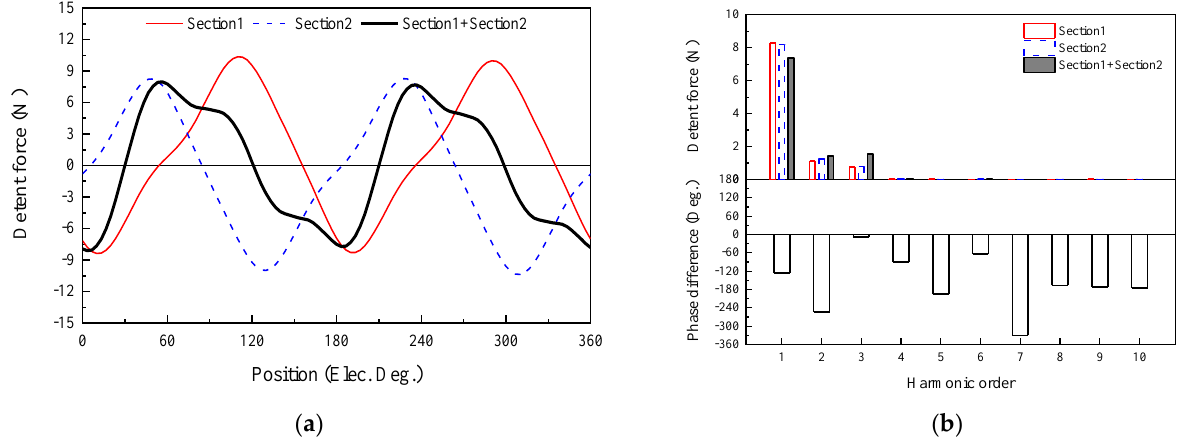
Figure 7. Detent force of Model 3: ( a ) detent force waveforms by sections; ( b ) detent force frequency decomposition.